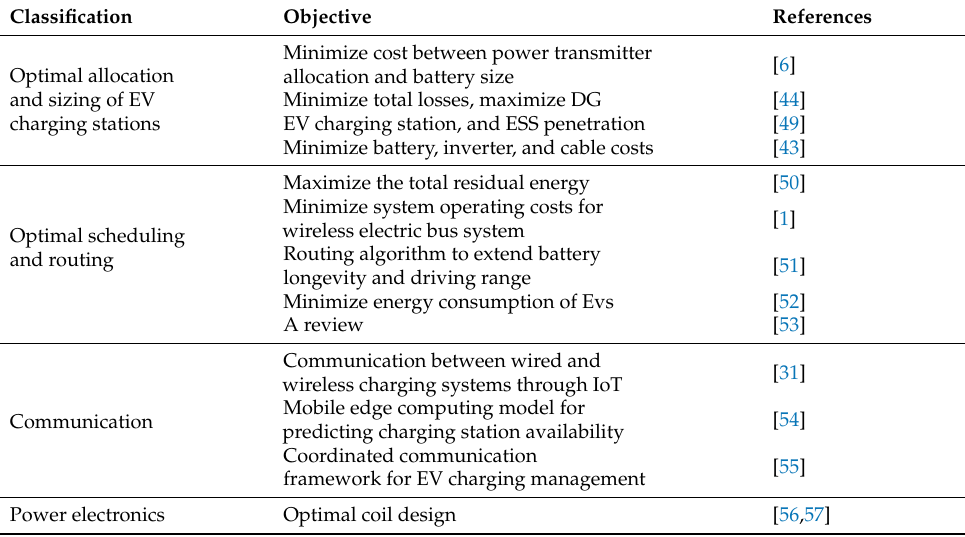
Table 7. Categories of wireless charging models in the literature.